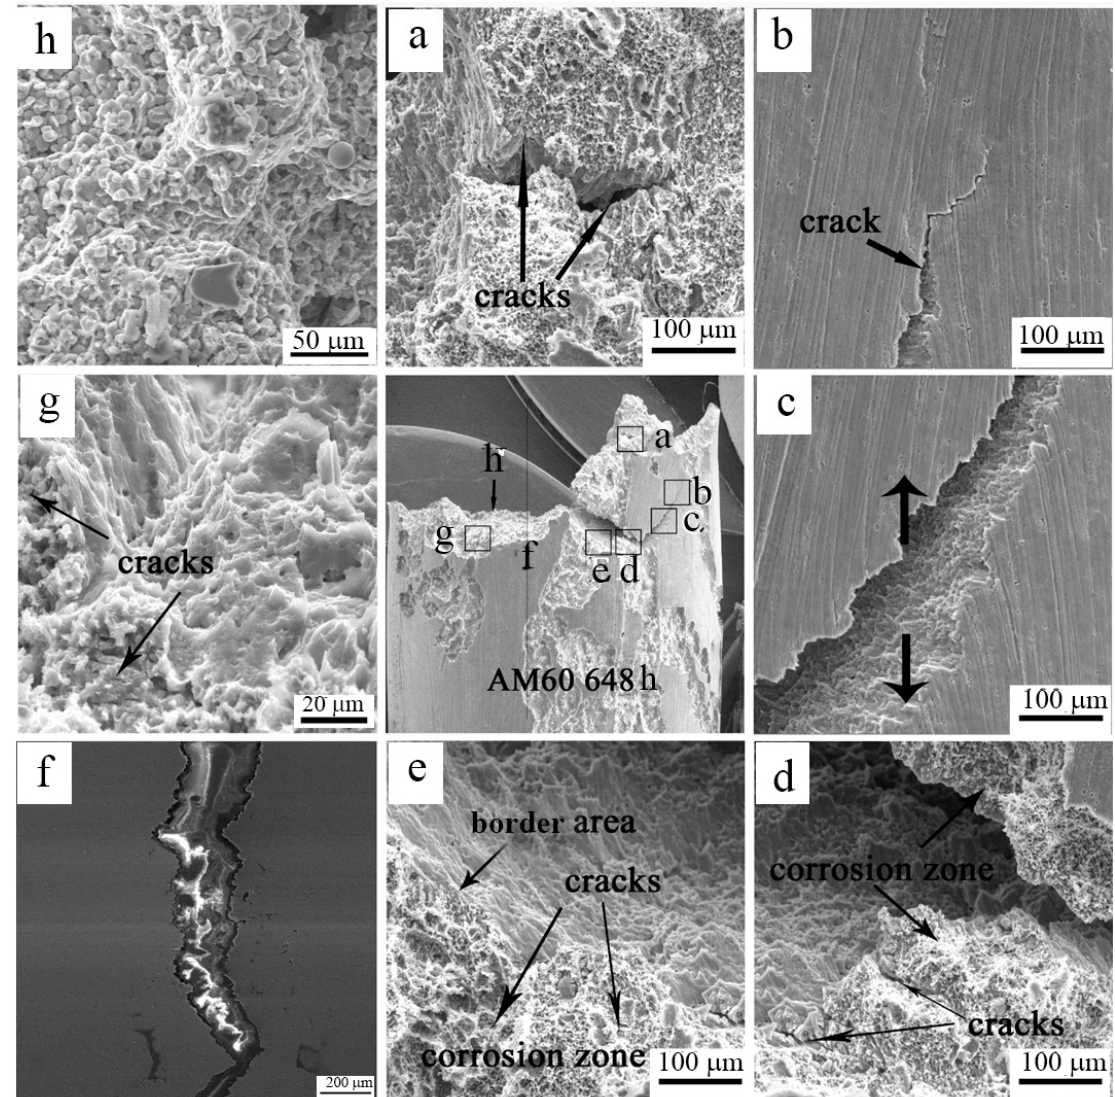
Figure 9. The tensile fracture surface of different zone ( a – h ) of HPDC AM60 magnesium alloy immersed in 3.5wt% NaCl solution for 648 h.